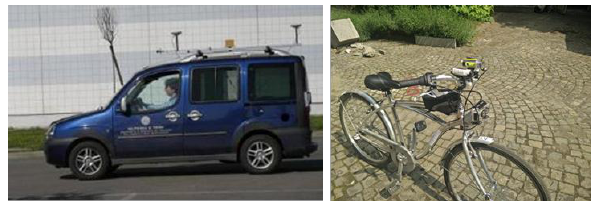
Figure 2. Mobile Mapping System on car and